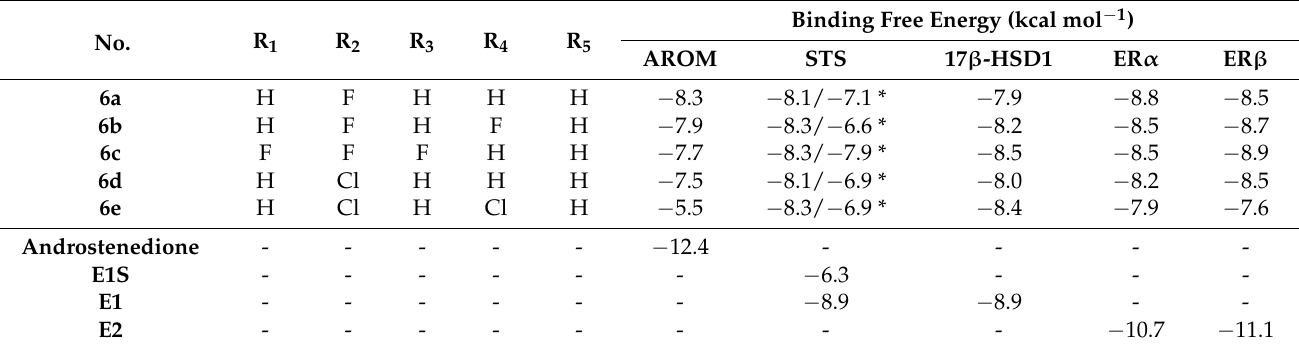
Table 2. Binding free energies of compounds 6a – e and references (androstenedione, estrone sulfate (E1S), estrone (E1) and, estradiol (E2)) to the AROM, STS, 17 β -HSD1, ER α , and ER β .